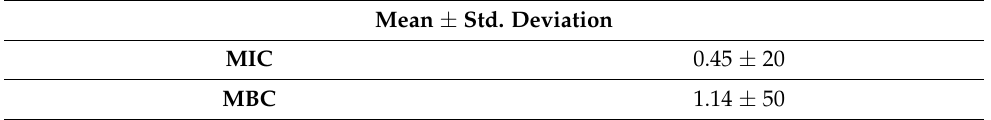
Figure 5. ( A ) Zone of inhibition (mm) of ZnO-NPs against Klebsiella pneumoniae (ATCC 700603) and tested bacteria. ( B ) MIC of ZnO-NPs against KPC and Klebsiella pneumoniae (ATCC 700603). ( C ) MBC of ZnO-NPs against KPC and Klebsiella pneumoniae (ATCC 700603). ( D ) The percentage of mean wound recovery in wound area within 14 days of wounding in Group 1 (infected and untreated control), Group 2 (infected and untreated control), Group 3 (infected and treated with imipenem), and Group 4 (infected and treated with ZnO-NPs). ( E ) Comparison between MIC and MBC. Table 2. Comparison between MIC and MBC.